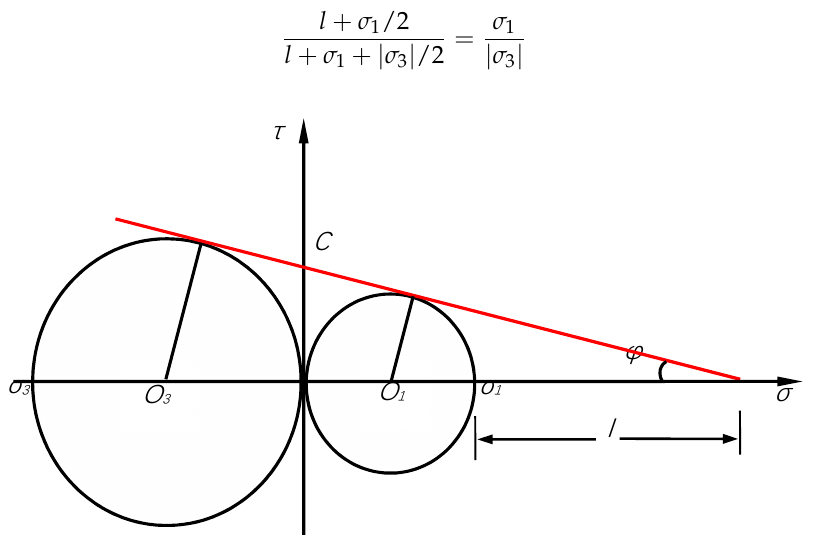
Figure 6. Mohr circle diagram for determining the values of C and φ through unconfined compressive and direct tensile strength.